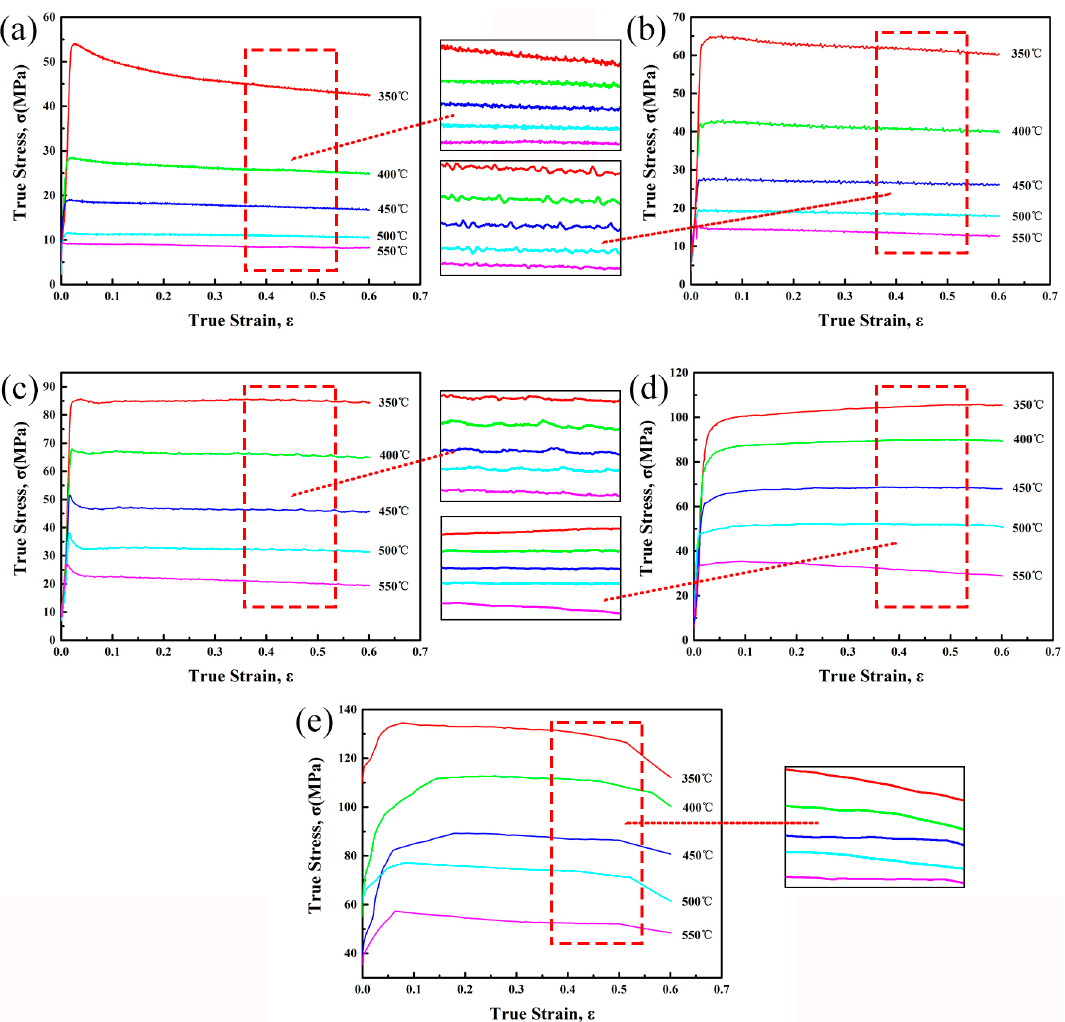
Figure 1. True stress–strain curves and magnified curves of the homogenized Al–7.5Zn–1.5Mg– 0.2Cu–0.2Zr alloy with different deformation temperatures at various strain rates of ( a ) 0.001 s − 1 ; ( c ) 0.1 s − 1 ; ( d ) 1 s − 1 ; and ( e ) 10 s − 1 ( b ) 0.01 s − 1 ; ( c ) 0.1 s − 1 ; ( d ) 1 s − 1 ; and ( e ) 10 s − 1 .